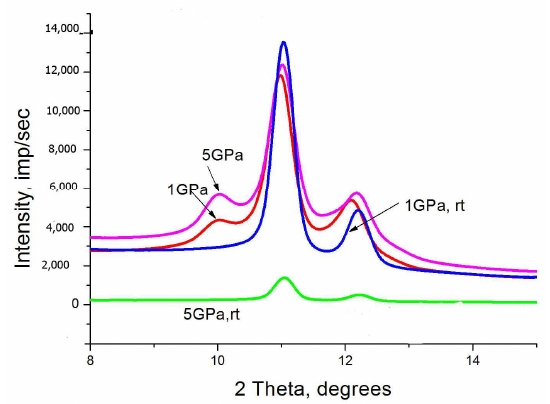
Figure 7. WAXS patterns of SC RP particles subjected to pressure 1 GPa and 5 GPa (shown by arrows) at room temperature. The WAXS patters designated as 1 GPa, rt and 5 GPa, rt correspond to WAXS patterns recorded at room temperature from the particles quickly cooled down to 300 K after heating.